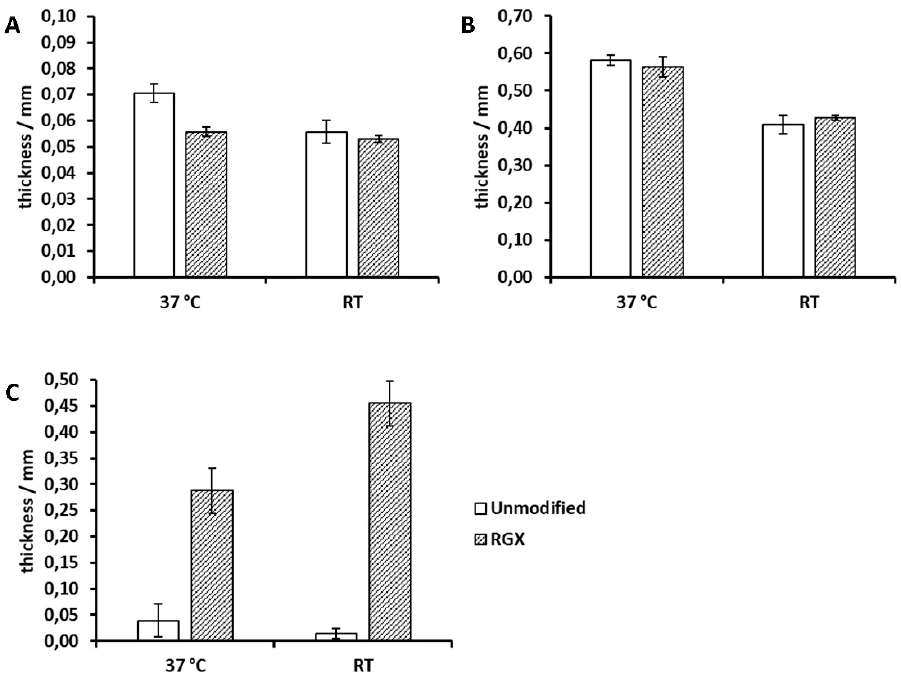
Figure 5. Thickness of unmodified and modified (RGX: 10 min, 0.01% RB) collagen sheets at 37 °C and RT. Samples were conditioned in PBS for 24 h before measurement. ( A ): Collagen Solutions, ( B ): Viscofan, ( C ): Atelocollagen.